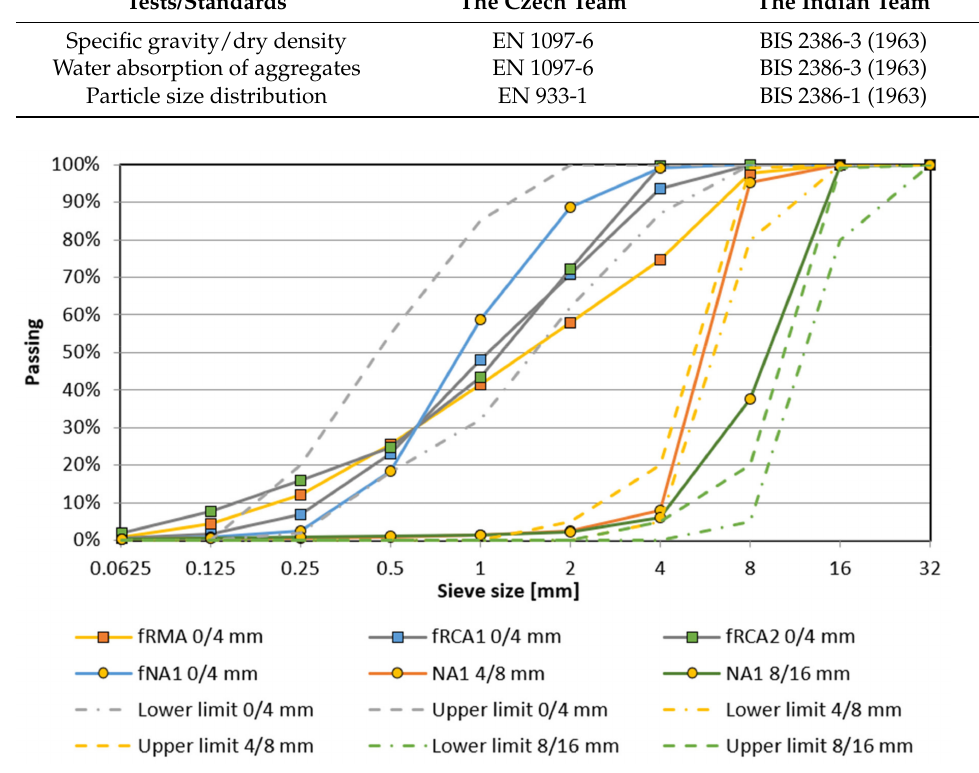
Figure 2. Particle size distribution of aggregates used by the Czech